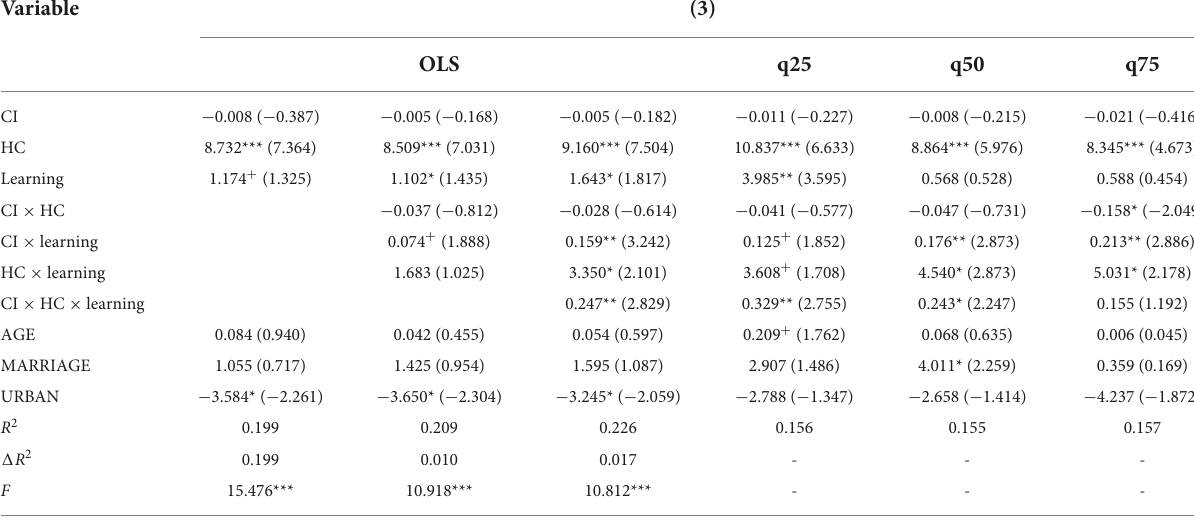
TABLE 6 Analysis of the secondary moderating impact of learning-oriented new media use. Variable